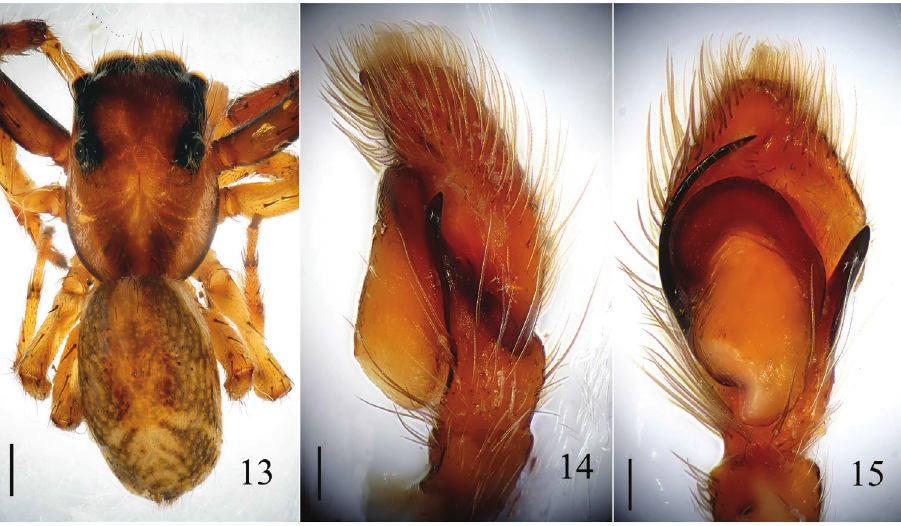
Figures 13–15. Yaginumaella pseudoflexa sp. n. 13 male body, dorsal view 14 male palp, retrolateral view 15 male palp, ventral view. Scale bars: ( 13 ) 0.5 mm; ( 14, 15 ) 0.1 mm.